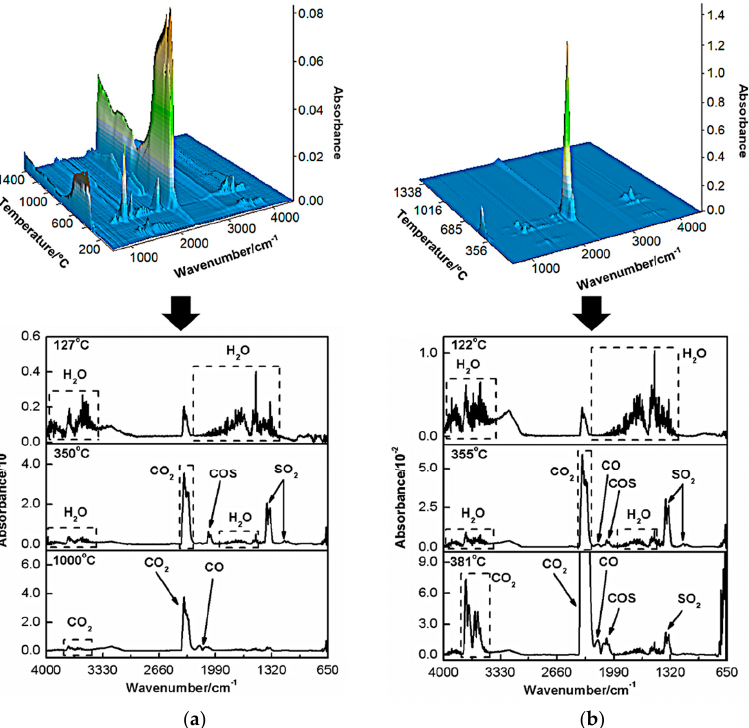
Figure 4. The 3D-2D FTIR spectra of gas products released during thermal decomposition of 1 in helium ( a ) and in air ( b ).